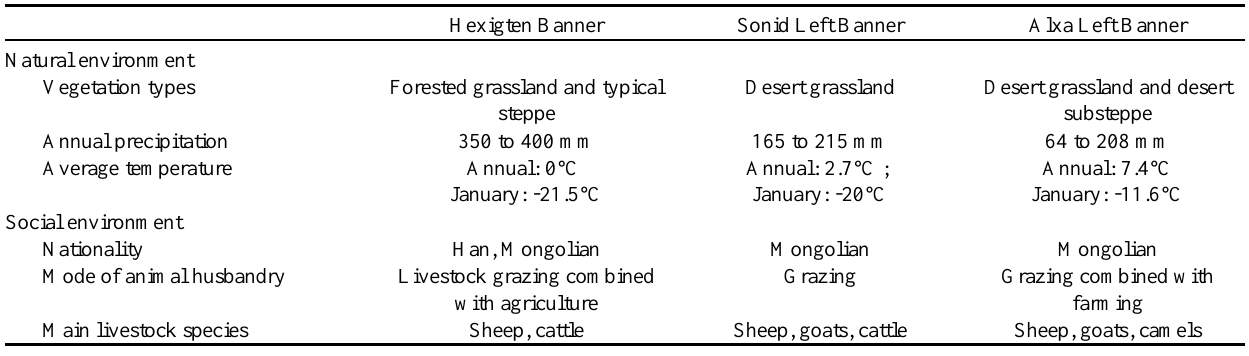
Table 1 . The basic natural and socioeconomic characteristics of the three case study sites.